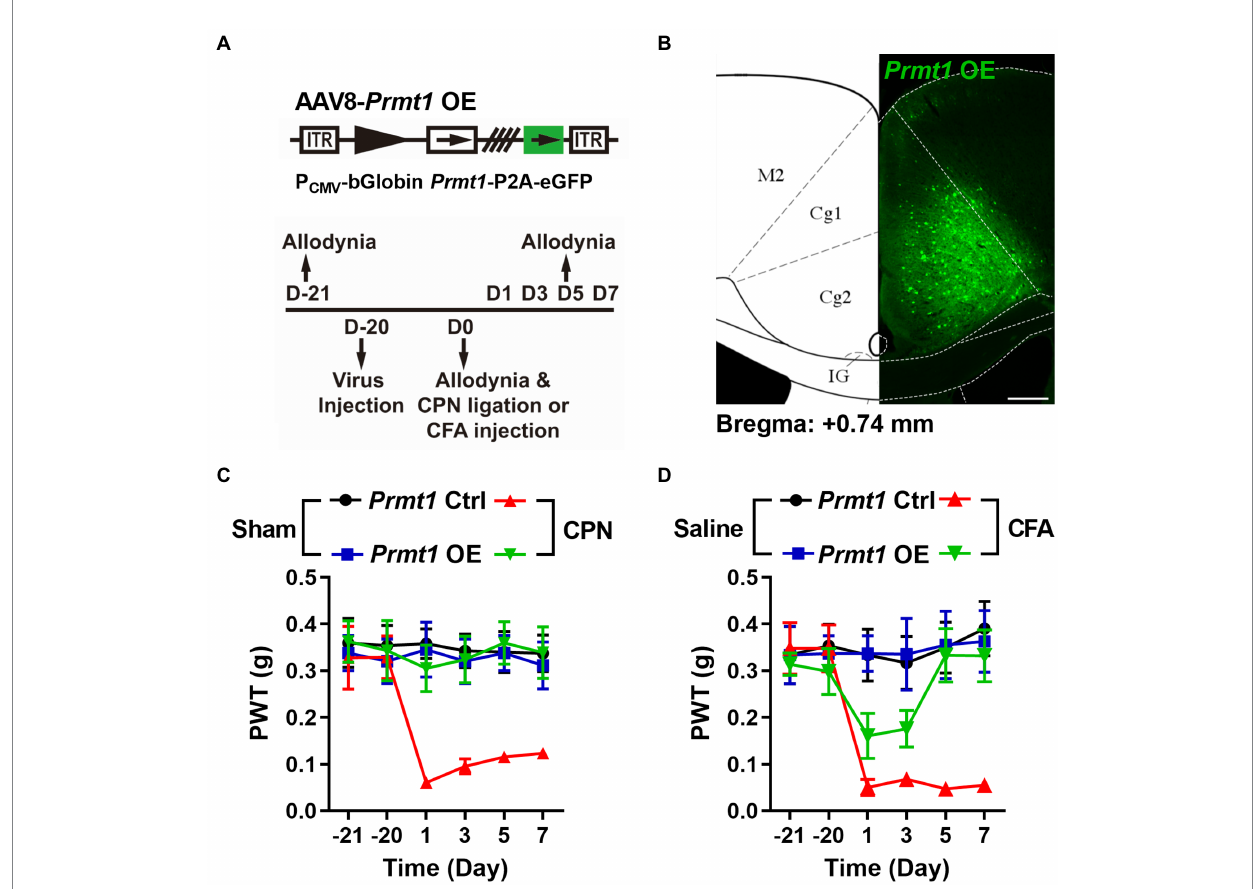
FIGURE 5 Downregulation of cingulate PRMT1 is necessary to develop peripheral hypersensitivity. (A) Upper schematics of AAV8 vectors engineered to overexpress PRMT1 and an eGFP Ctrl. Lower experimental paradigm for behavioral testing. (B) Illustration of bilateral AAV8- Prmt1 OE virus in the mouse ACC. (C) PWT tests conducted in both sham and CPN-ligated mice injected either Prmt1 Ctrl or OE virus in ACC (Sham Prmt1 Ctrl, n = 9; Sham Prmt1 OE, n = 8; CPN Prmt1 Ctrl, n = 9; CPN Prmt1 OE, n = 8, Two-way RM ANOVA, interaction: F (15;150) = 2.0, p < 0.05, Time: F (5;150) = 2.70, p < 0.05, Prmt1 Ctrl vs. Prmt1 OE: F (3;150) = 15.60, p < 0.01). (D) PWTs measured in both saline-and CFA-injected mice either with Prmt1 Ctrl or OE virus in ACC (Saline Prmt1 Ctrl, n = 6; Saline Prmt1 OE, n = 6; CFA Prmt1 Ctrl, n = 8; CFA Prmt1 OE, n = 10, Two-way RM ANOVA, interaction: F (15;130) = 3.40, p < 0.01, Time: F (5;130) = 4.72, p < 0.01, Prmt1 Ctrl vs. Prmt1 OE: F (3;130) = 11.41, p < 0.01). Data are represented as mean ± SEM; ns, not